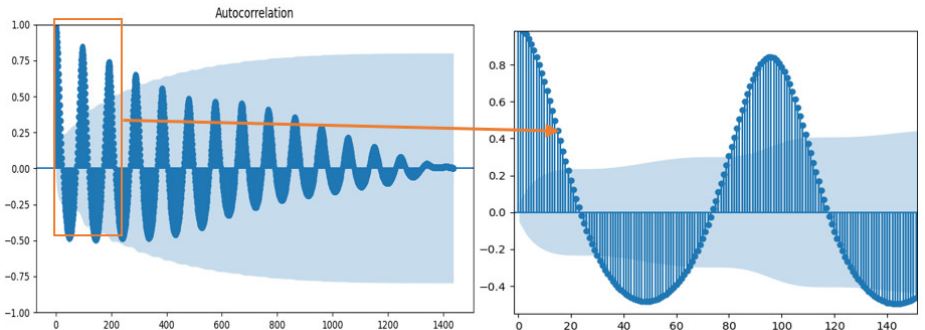
Figure 7. Autocorrelation coefficient diagram of power load of Taoyuan substation in Nanchang. Table 1. Correlation analysis of power load in five adjacent time steps.